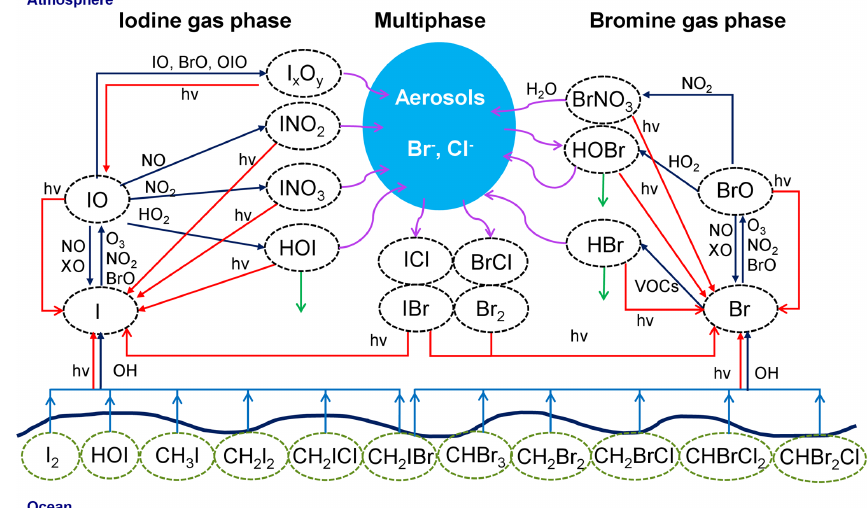
Figure 4. Schematic representation of the implemented iodine and bromine chemistry in WRF-Chem. Chlorine chemistry has been included into the model; since our results are mainly focused on reactive bromine and iodine, we decided not to include chlorine chemistry in this figure. Red lines represent photolytic reactions, dark blue lines gas-phase pathways, light blue lines fluxes, green lines deposition and purple curved lines heterogeneous